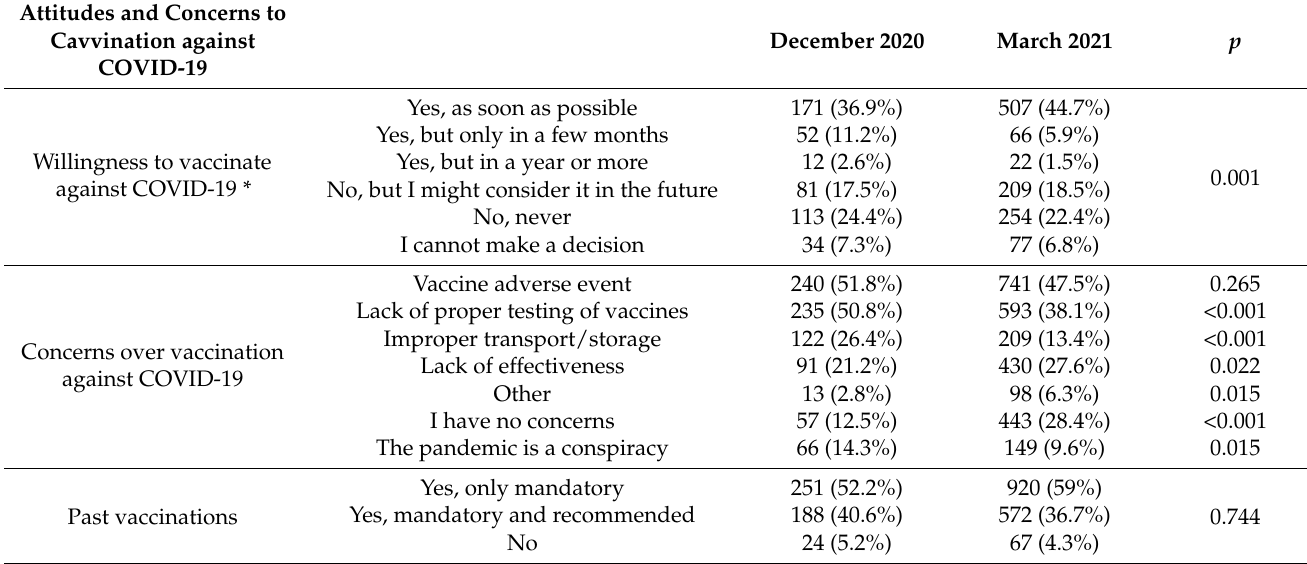
Table 2. Comparison of attitudes and concerns related to vaccination against COVID-19 in both stages of the study. Attitudes and Concerns to Cavvination against